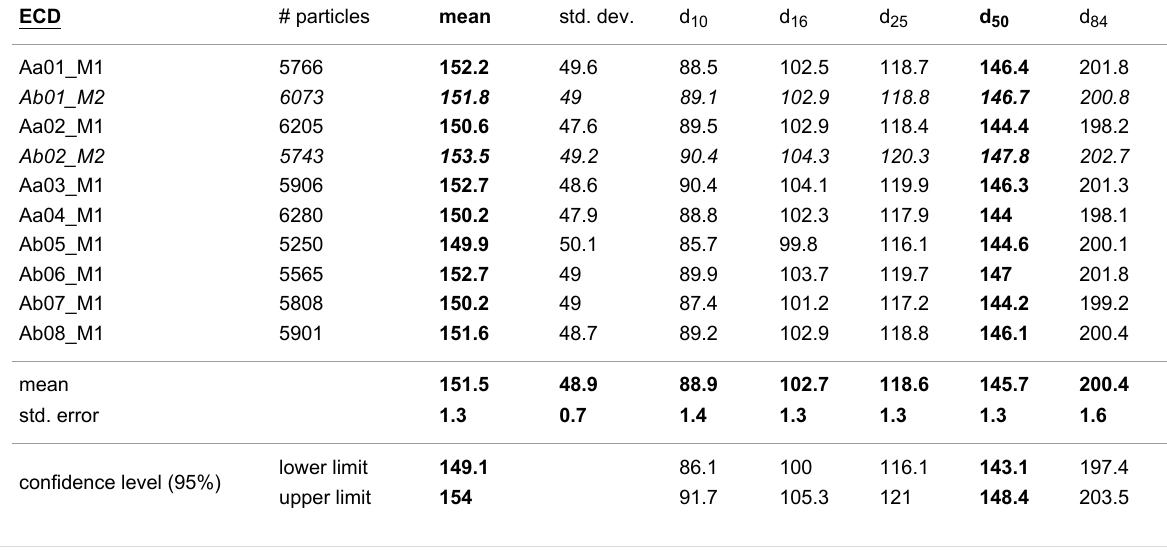
Table 3: Evaluation of the primary particle sizes of KRONOS K1171 in terms of the equivalent circle diameter (ECD); all values given in nm. ECD # particles mean